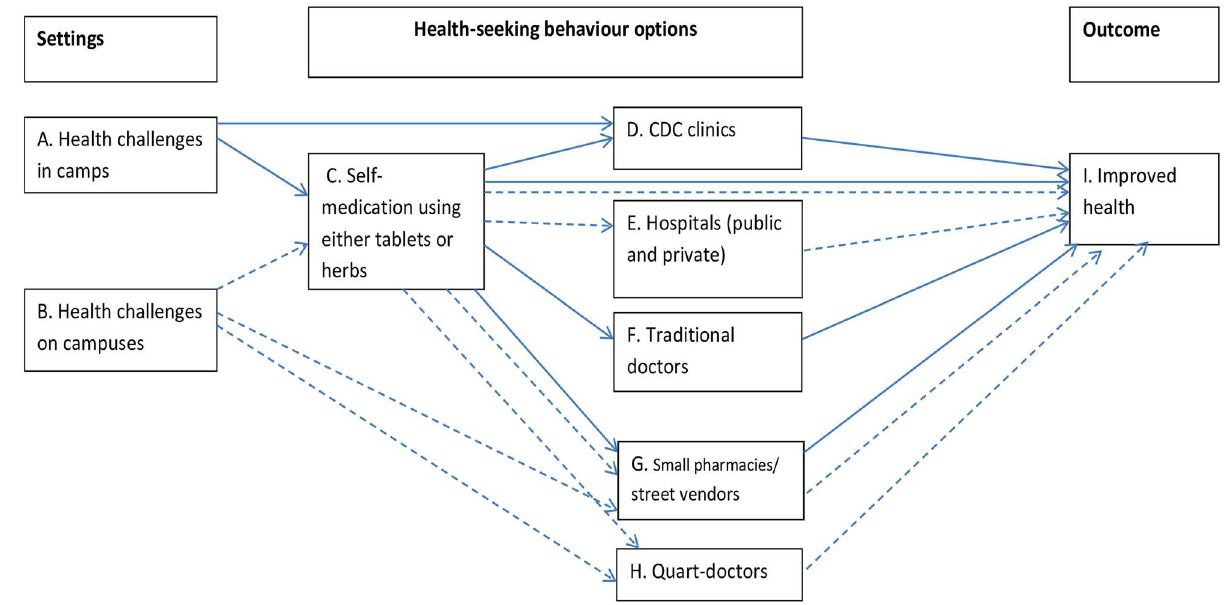
Fig 1. Schematic model of dynamics of HSB in camps and on